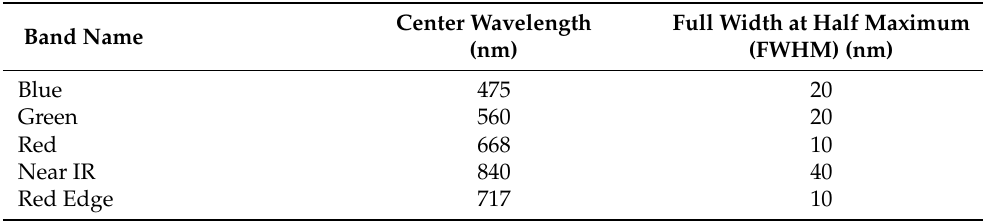
Table 3. Spectral bands in which the MicaSense RedEdge multispectral camera operates (courtesy